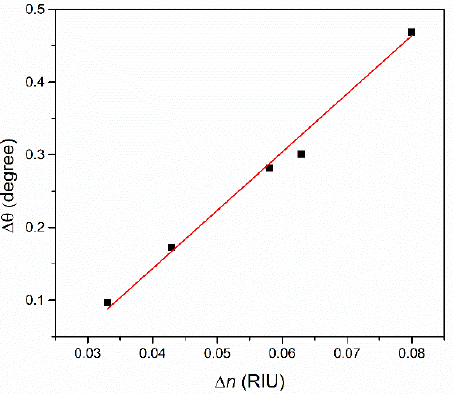
Figure 14. Sensitivity for the NCC-based thin film in contact with copper ion using